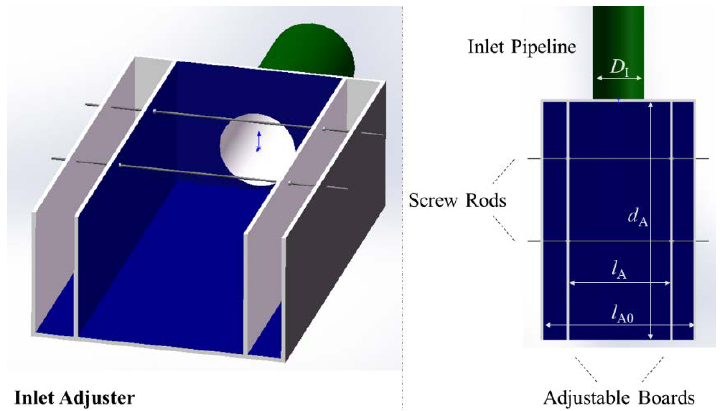
Figure 3. Detailed description of the inlet adjuster.